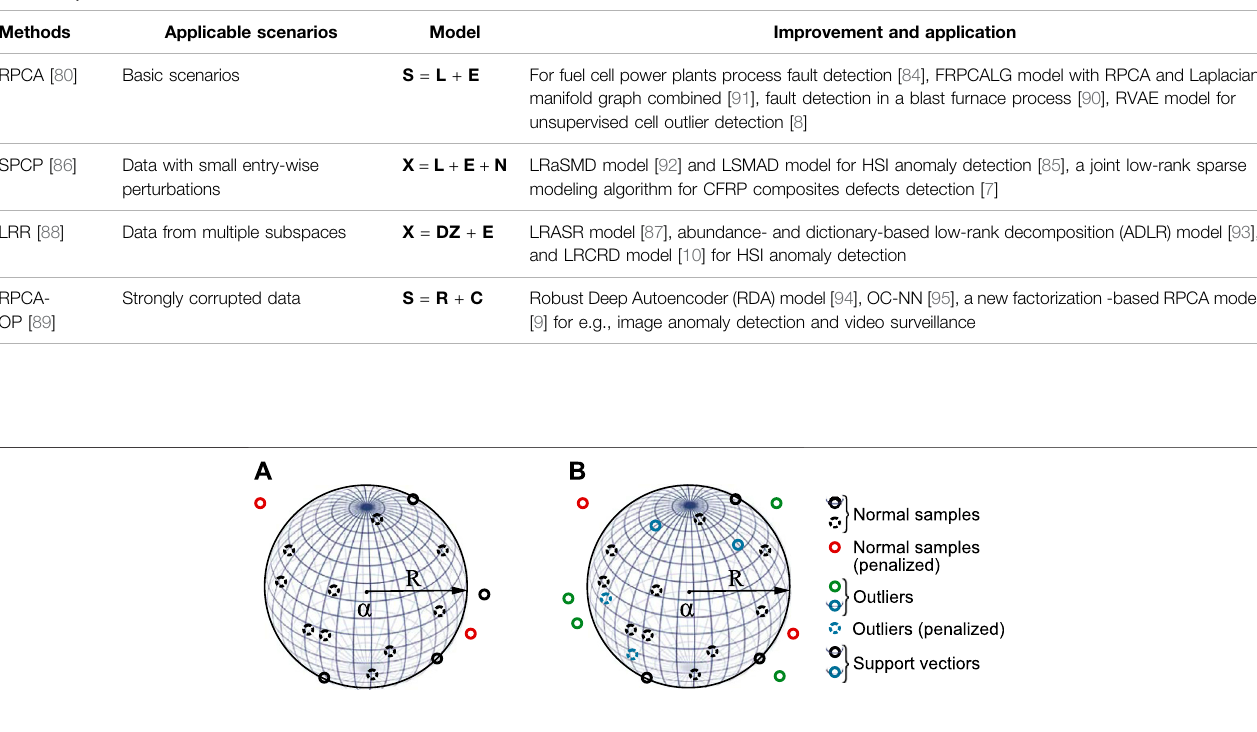
FIGURE5| Supportvectorsphericaldescriptionbasedonthetrainingset: (A) SVDDand (B) NSVDD.Thedashedcirclesrepresentsamplesinthedescriptionand thesolidcirclesonandoutsidethedescription.ThecirclesonthedescriptionareSVs(i.e.,asolidcirclecrossedbyacurve)containingbothtargetsamplesandoutliersin (B) NSVDD.Thesupportvectordomain method penalizesobservations notinthecorrectposition,i.e., redcirclesin (A) SVDDand (B) NSVDDbecausenormal samples should be inside the description, and blue dashed circles in (B) NSVDD because outliers should fall outside the description.